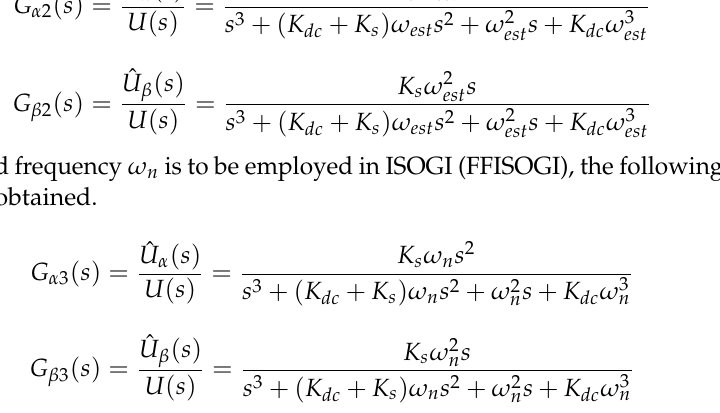
Figure 7. The improved FFPLL1 with the DC offset compensation.